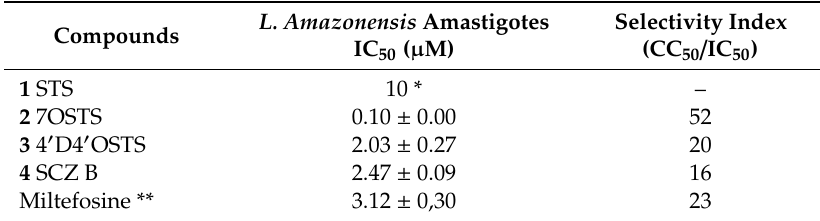
Table 3. Leishmanicidal e ff ect of ICZs 1 - 4 against the intracellular stage (amastigotes), and its comparison with the reference drug by the selectivity index (CC 50 / IC 50